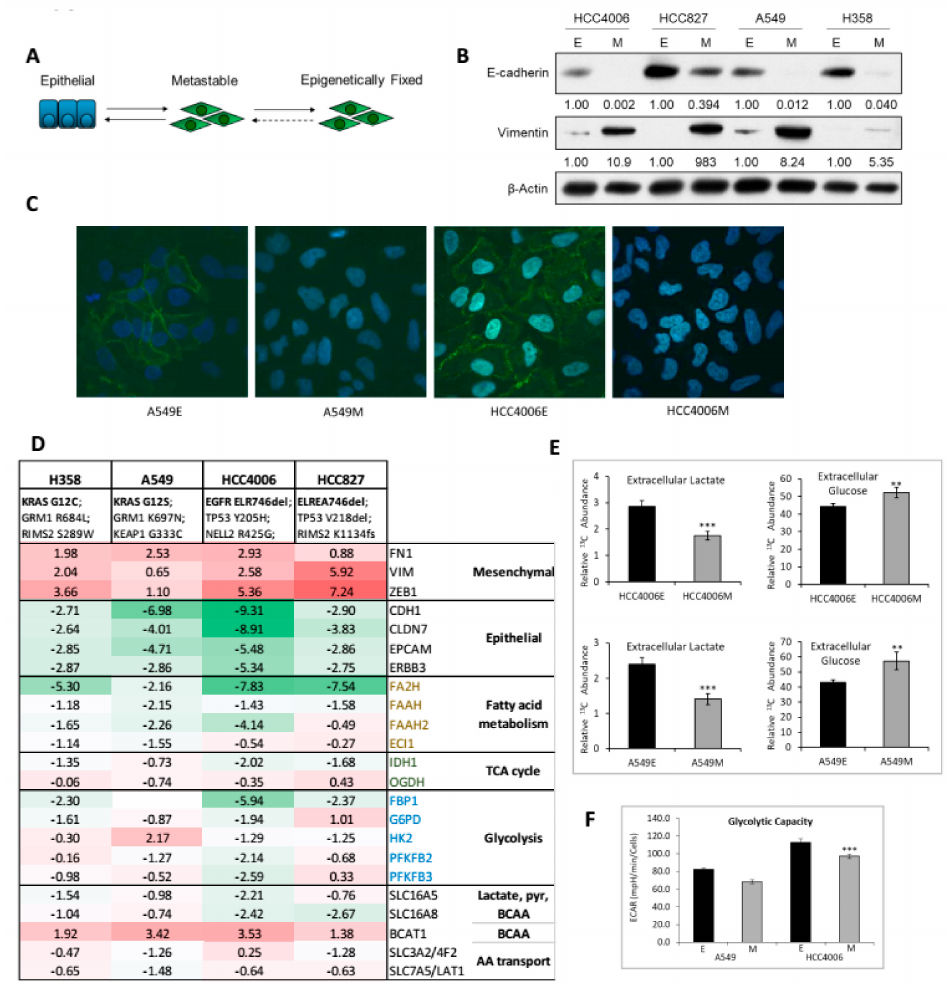
Figure 1. Isogenic mutant KRAS and EGFR model systems show altered metabolic RNA expression and attenuated glycolytic capacity when in a mesenchymal-like cell state. ( A ) Epithelial tumor cells can trans-di ff erentiate to reversible / metastable and epigenetically ‘fixed’ mesenchymal cell states. ( B ) NSCLC isogenic mutant KRAS and EGFR models display epithelial or mesenchymal protein markers dependent on state. ( C ) Plasma membrane localization of E-cadherin (green) is lost in the mesenchymal state. Nuclei are stained with DAPI (blue). ( D ) RNA abundance characteristics of the four isogenic lung E-and M-state models (log2M / E fold change; bold values indicate FDR adjusted q value < 0.05). Selected metabolic RNA changes associated with M and E cell state. Glycolytic and pentose phosphate pathway M state RNA expression decreases, included phosphofructokinase PFKFB2 / 3), hexokinase-2(HK2), and glycerol 6-phosphate dehydrogenase (G6PD). TCA cycle IDH1 and OGDH, and lipid synthesis FA2H, FAAH, FAAH2, and ECI1 also were reduced in M state cells. ( E ) In HCC4006 and A549 labeled with 13C6-glucose, extracellular lactate and glucose levels decrease in M state by GC-MS. Isotopologue distributions are shown in Supplementary Figure S2. ( p < 0.05 *; p < 0.01 **; p < 0.001 ***). ( F ) In HCC4006 and A549 glycolytic capacity decreases in the M